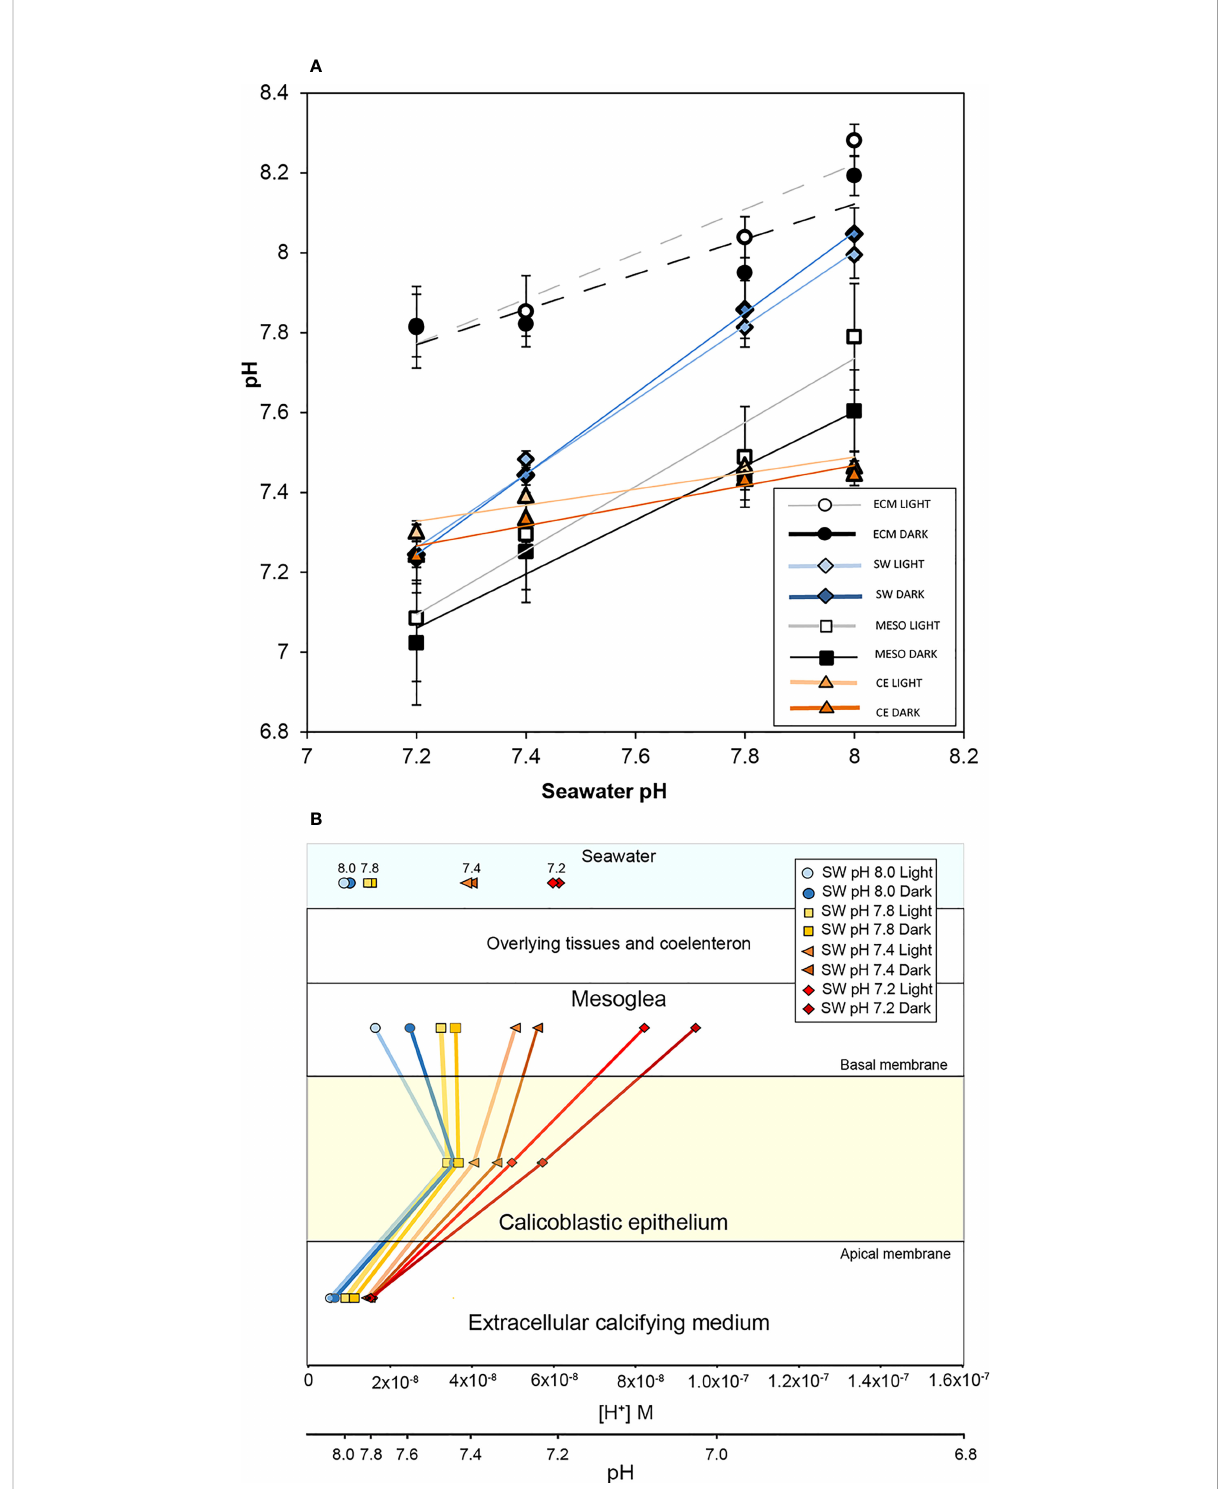
FIGURE 2 The effect of seawater acidi fi cation in light and darkness on the pH gradient across the calcifying epithelium of S. pistillata . (A) pH (means ± SD) in the mesoglea (MESO), seawater surrounding the corals in the perfusion chamber (SW), the extracellular calcifying medium (ECM) and the calicoblastic epithelium (CE). ECM and CE values taken from Venn et al. (2019). A linear regression is drawn for each data set to display the trend. (B) Mean pH values from panel (A) plotted against parallel [H + ] and pH scales to illustrate the proton gradient across the